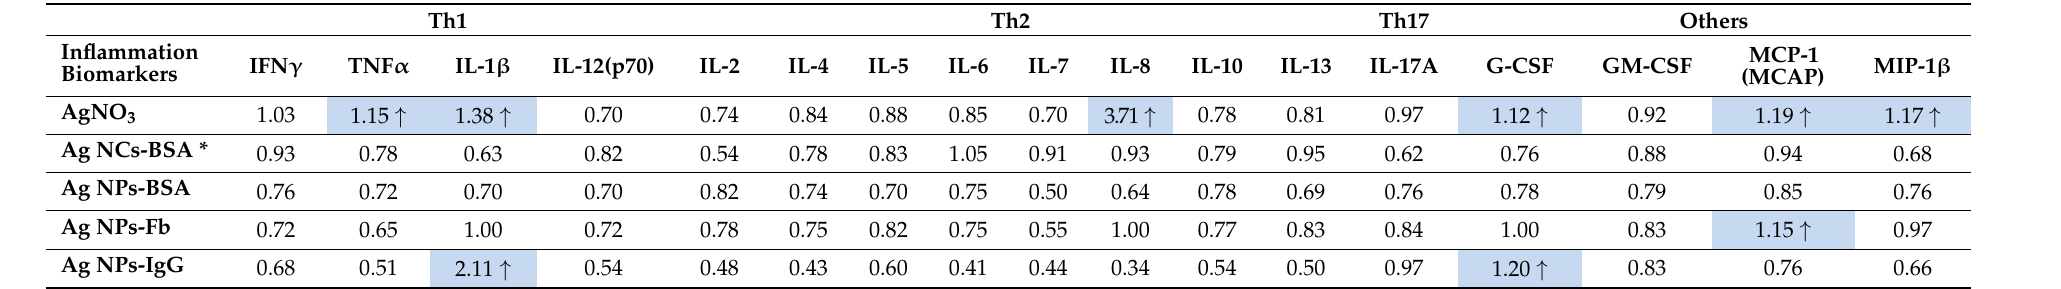
Table 3. Unknown (X) Multi Analyte Profiling (xMAP) results for 17 inflammation biomarkers in HEp-2 cells in 2 days posttreatment. Normalization was carried out as a ratio of mean fluorescence intensity (MFI) for wells after incubation with the nanosilver to MFI of control intact HEp-2 cells.